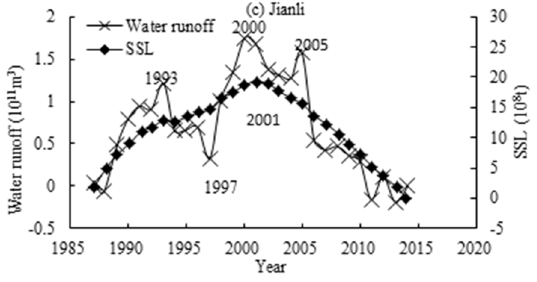
Figure 7. Mass curves of anomalies of runoff and SSL at Zhicheng ( a ), Shashi ( b ), and Jianli ( c ) hydrological stations (1987–2014).